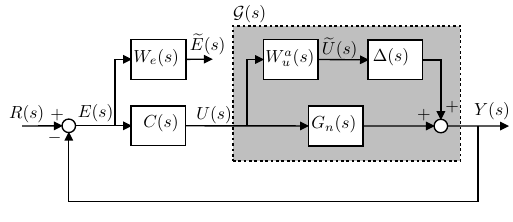
Figure 10. Feedback configuration with additive unstructured